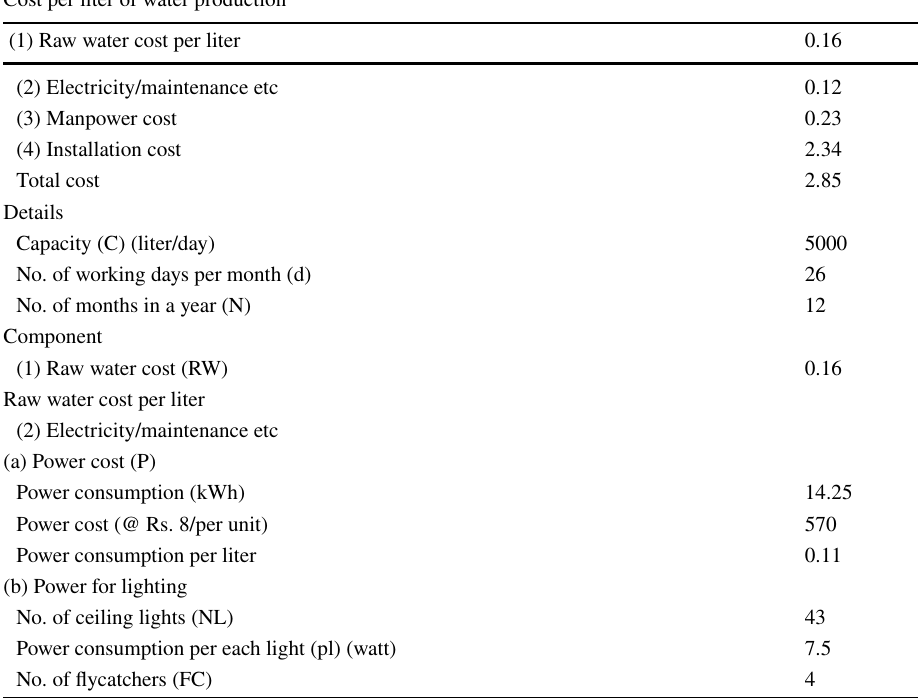
estimation of pilot plant for production of